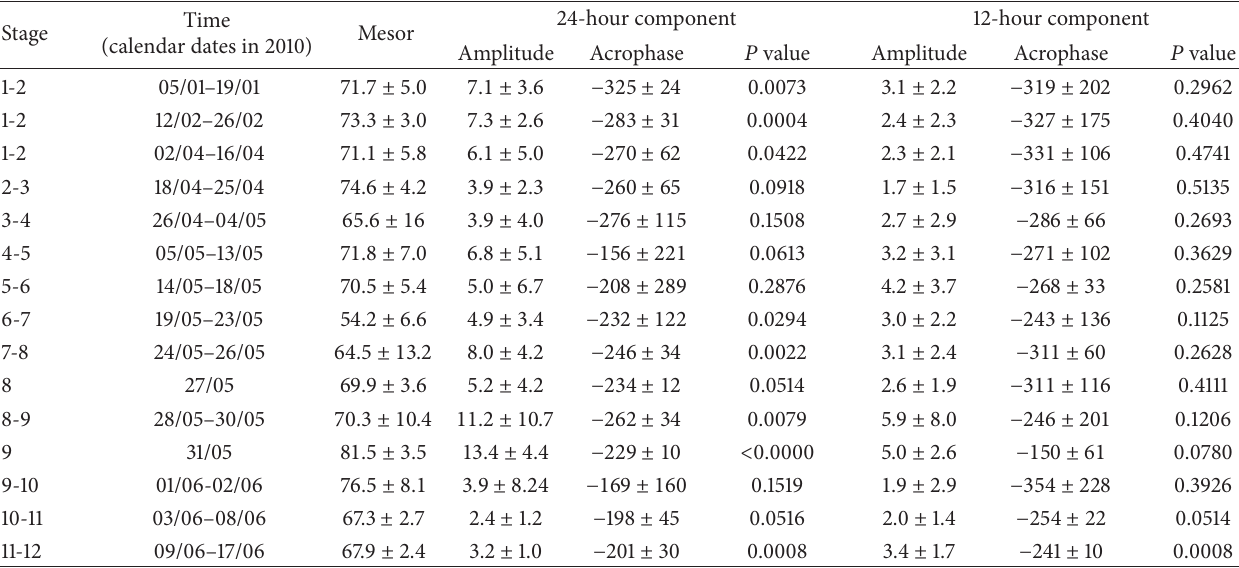
Table 3: Dynamics of the heart rate in